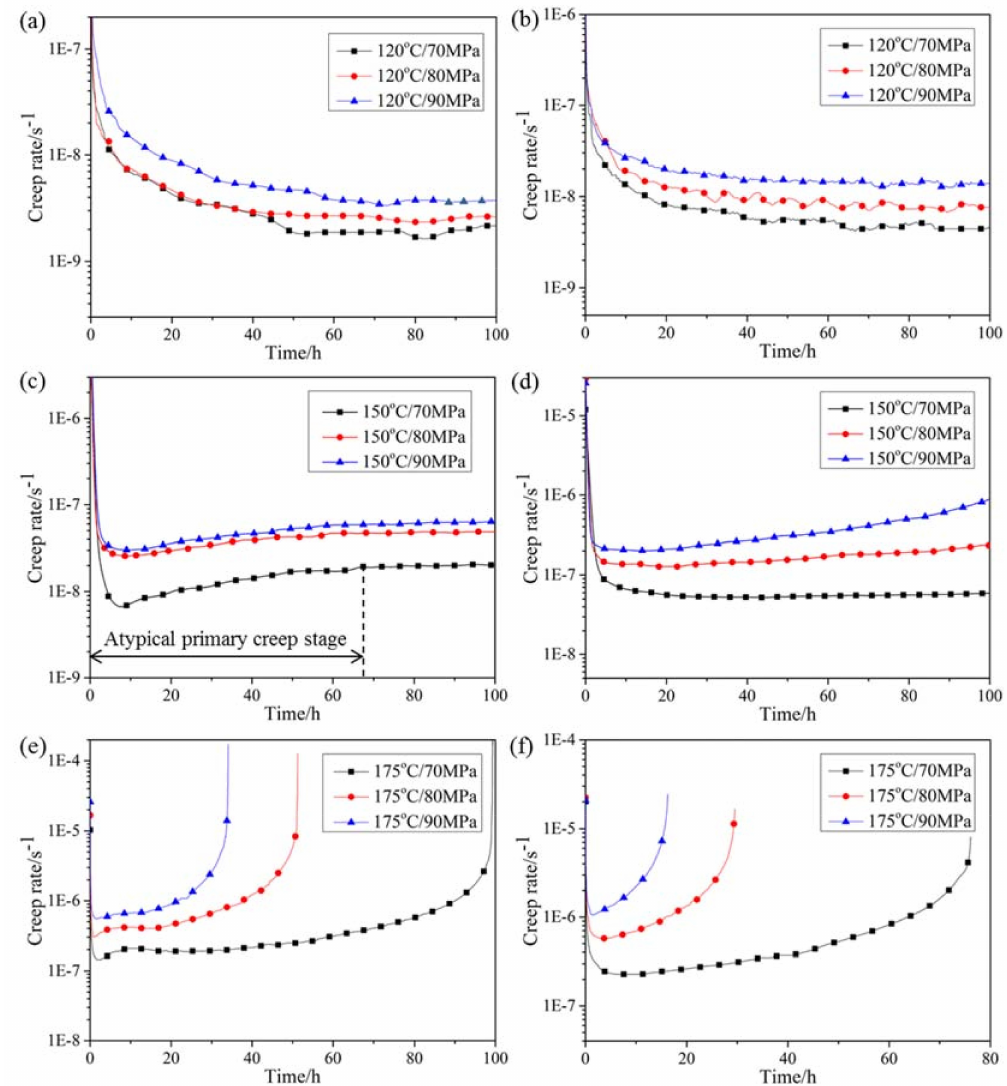
Figure 5. Creep rate versus time plots of ( a , c , e ) HRRed and ( b , d , f ) T5 specimens tested at 120–175 ◦ C and under 70–90